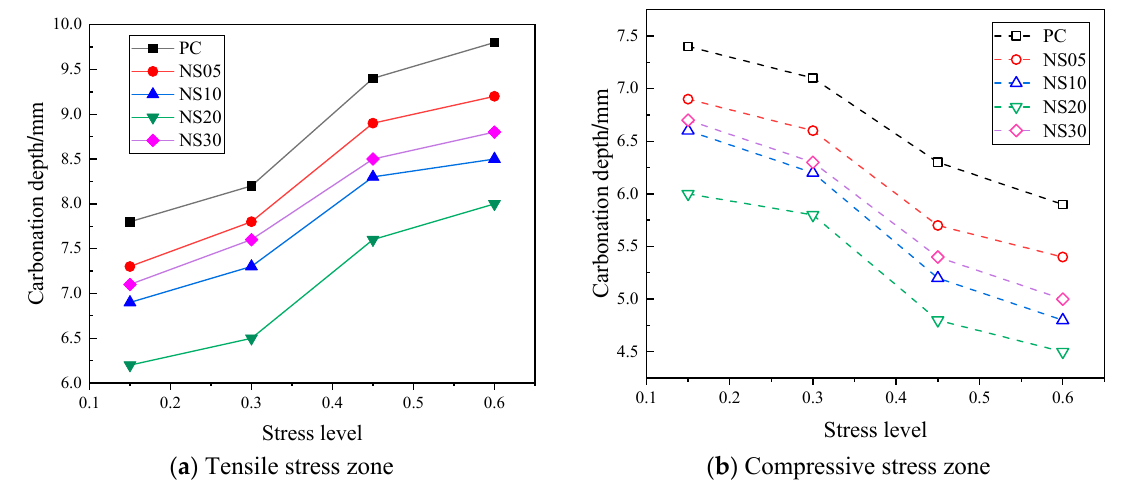
Figure 6. Relationship between carbonation depth of nano-concrete and stress variation (age: 28 days).